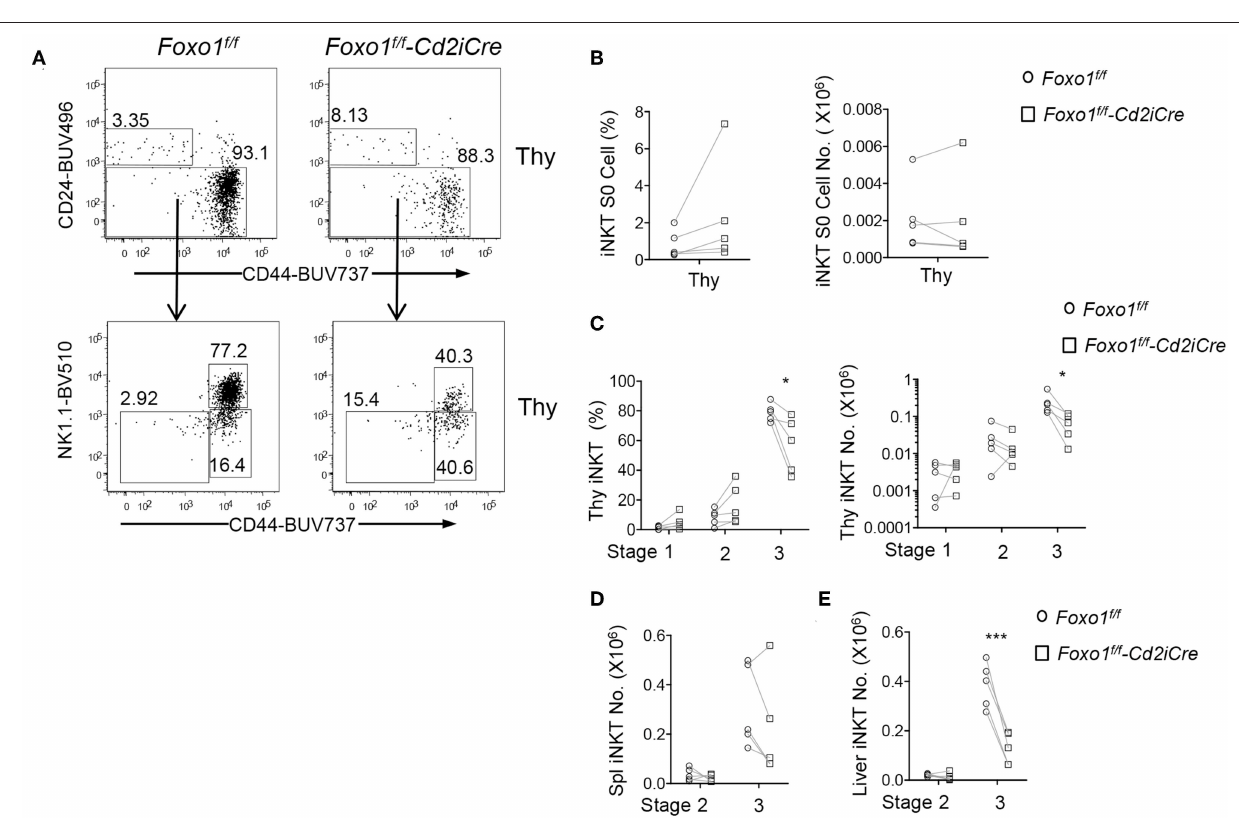
FIGURE 3 | Impaired late stage i NKT cell development in Foxo1 f / f -Cd2iCre mice. Six to ten weeks old Foxo1 f / f -Cd2iCre and control mice were analyzed similar to Figure 1 with additional antibodies for CD24, CD44, NK1.1, and CD11b, CD11, F4/80, Ter119 for lineage gating. (A) Top panels: CD24 vs. CD44 staining of live gated Lin − i NKT cells in the thymus. Bottom panels, CD44 vs. NK1.1 staining on CD24 − i NKT cells. (B) Stage 0 i NKT percentages and numbers in the thymus. (C) Stages 1, 2, and 3 i NKT cell percentages and numbers in the thymus. (D) Stages 2 and 3 i NKT cell numbers in the spleen. (E) Stages 2 and 3 i NKT cell numbers in the liver. Data shown are representative or pooled from five experiments. Connecting lines indicate individual pairs of sex- and age-matched test and control mice in each experiment. * p < 0.05; *** p < 0.001 determined by two-tail pair-wised Student t